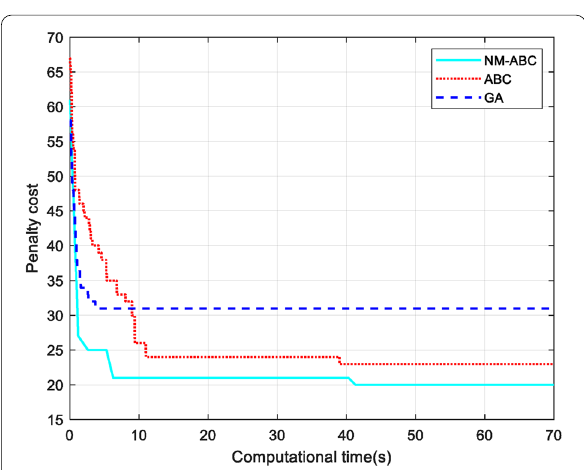
Figure 9 The convergence curve